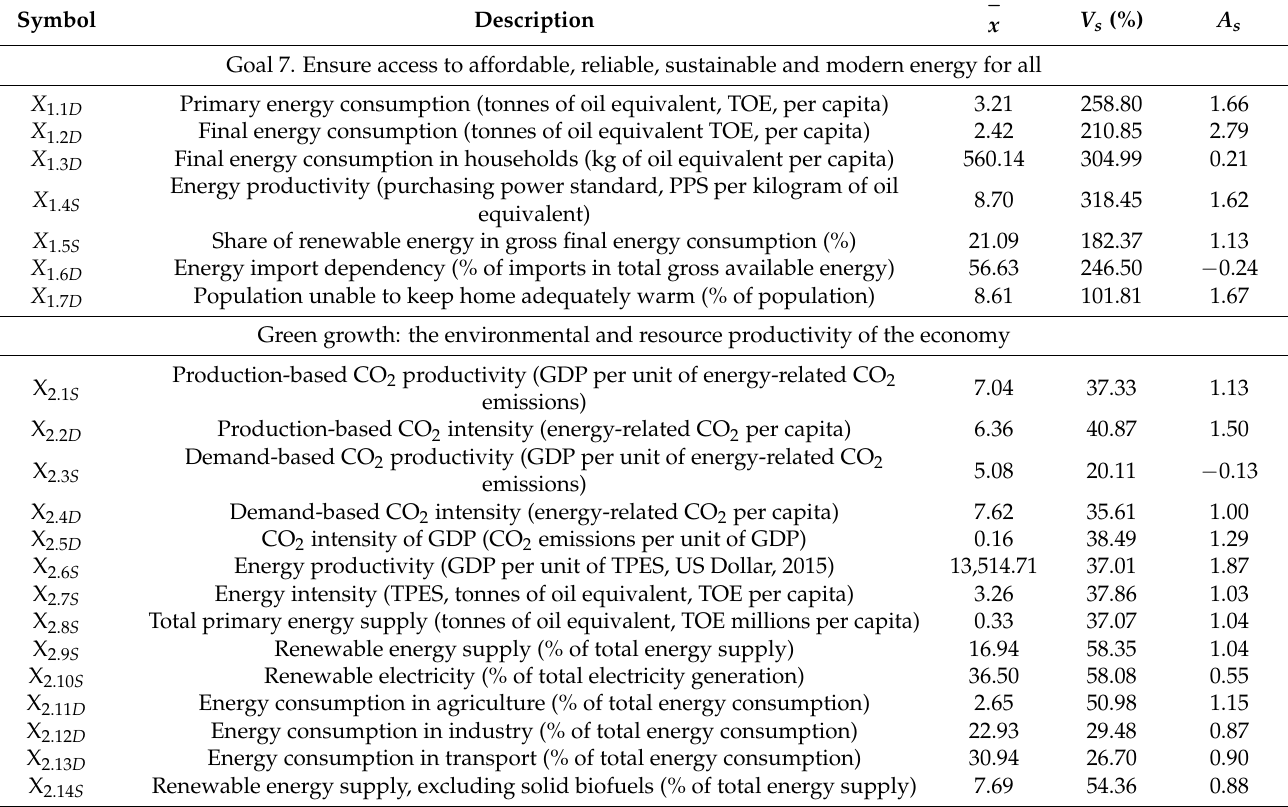
Table 2. Descriptive characteristics of indicators analyzed in the paper, EU countries and the United Kingdom, 2018 1 . Symbol Description